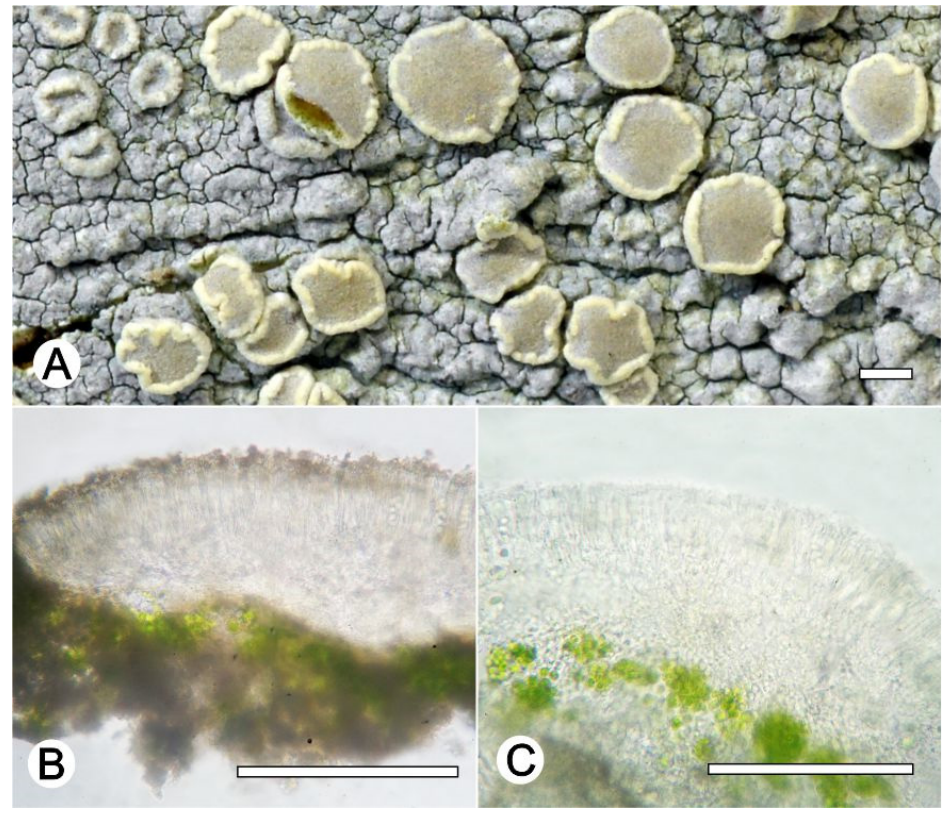
Figure 4. Lecanora glaucomodes . ( A ) Thallus with ascomata (ISE-46533); ( B ) Apothecial section in water (ISE-46533); ( C ) Apothecial section after KOH treatment (ISE-46533). Scale bars: ( A ), 1 mm; ( B , C ), 100 µm.